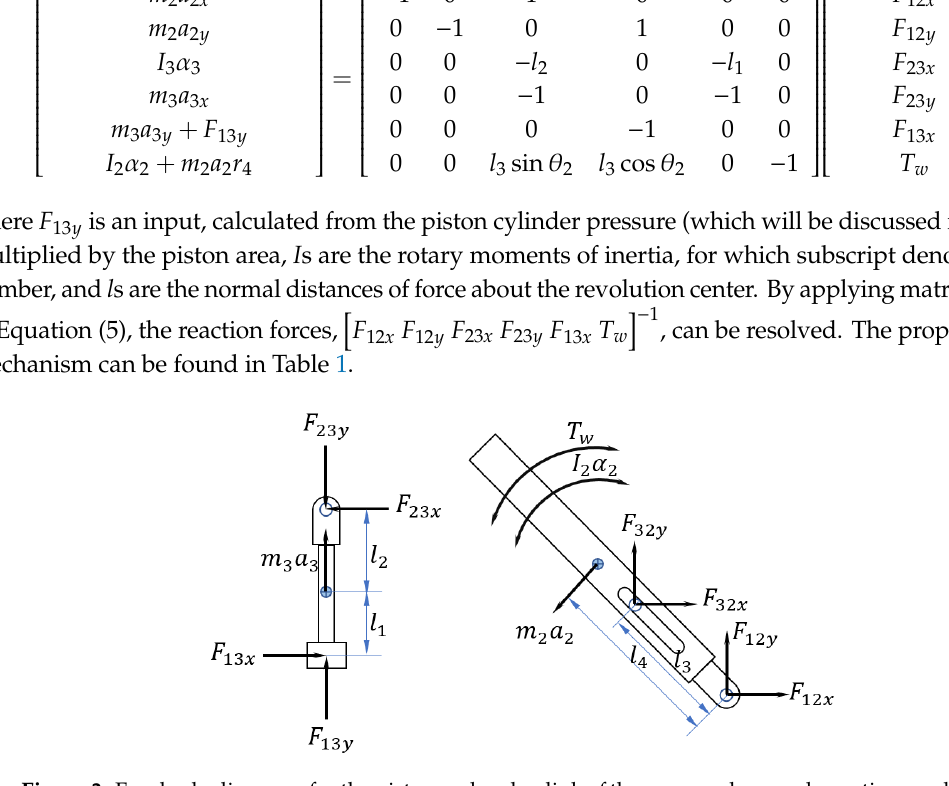
Figure3. Freebodydiagramsforthepistonandrockerlinkoftheproposedwaveabsorptionmechanism. Figure 3. Free body diagrams for the piston and rocker link of the proposed wave absorption mechanism. Table 1. Mechanism Table 1. Mechanism parameters.